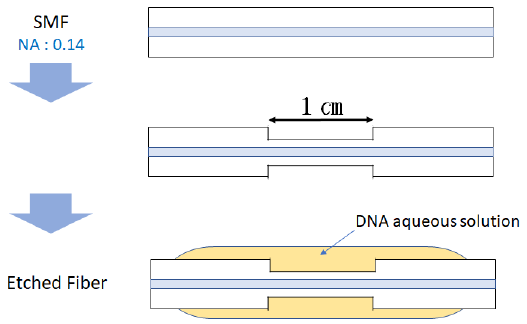
Figure 1. Fabrication process and cross-section of the DNA